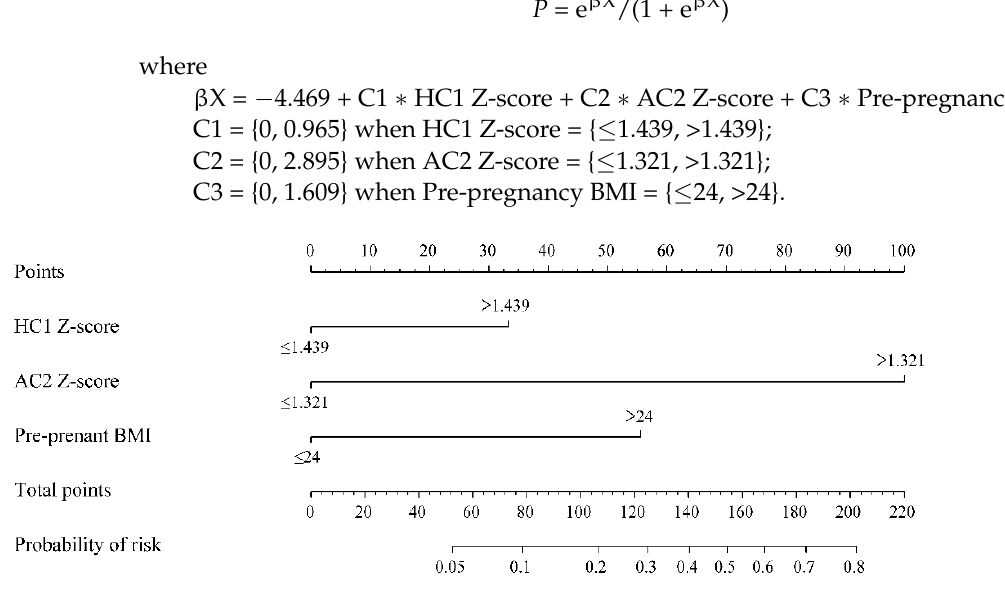
Figure 2. Nomogram for predicting an LGA infant in mothers with GDM. Directions: pre-pregnancy BMI, HC1 Z-score measured during GDM diagnosis, and AC2 Z-score measured within two weeks before delivery for an individual patient. Instructions: Each individual’s risk of delivering an LGA infant was estimated by plotting on each variable axis. The nomogram was able to predict LGA babies in pregnant women with GDM at the optimal cutoff values of HC1 Z-scores > 1.439, AC2 Z-scores > 1.321, and pre-pregnancy BMIs > 24, under which AGA babies could be considered. Points from each variable value were then summed. The sum of the total points scale was located and vertically projected onto the bottom axis. A probability risk for an LGA infant was then obtained.